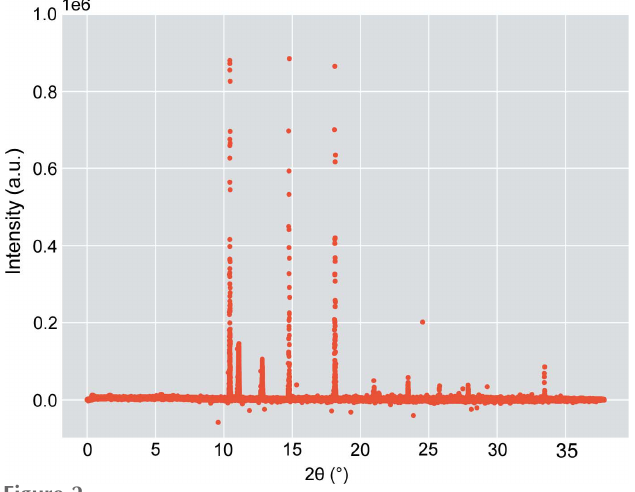
Figure 2 Plot illustrating the feature space of the 2D XRD pattern shown in Fig. 1 in which every point belongs to a pixel.